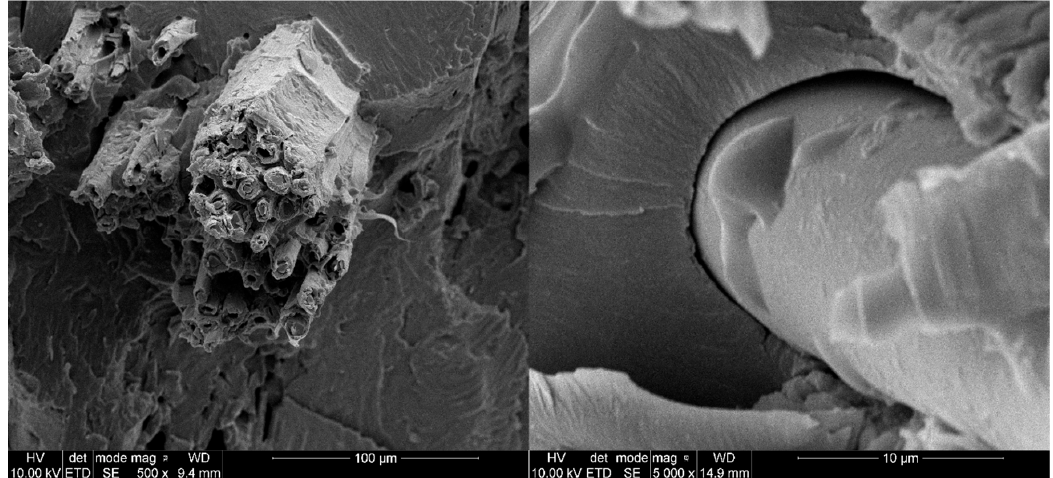
Figure 18. SEM images of glass and sisal fibers adhesion to matrix.